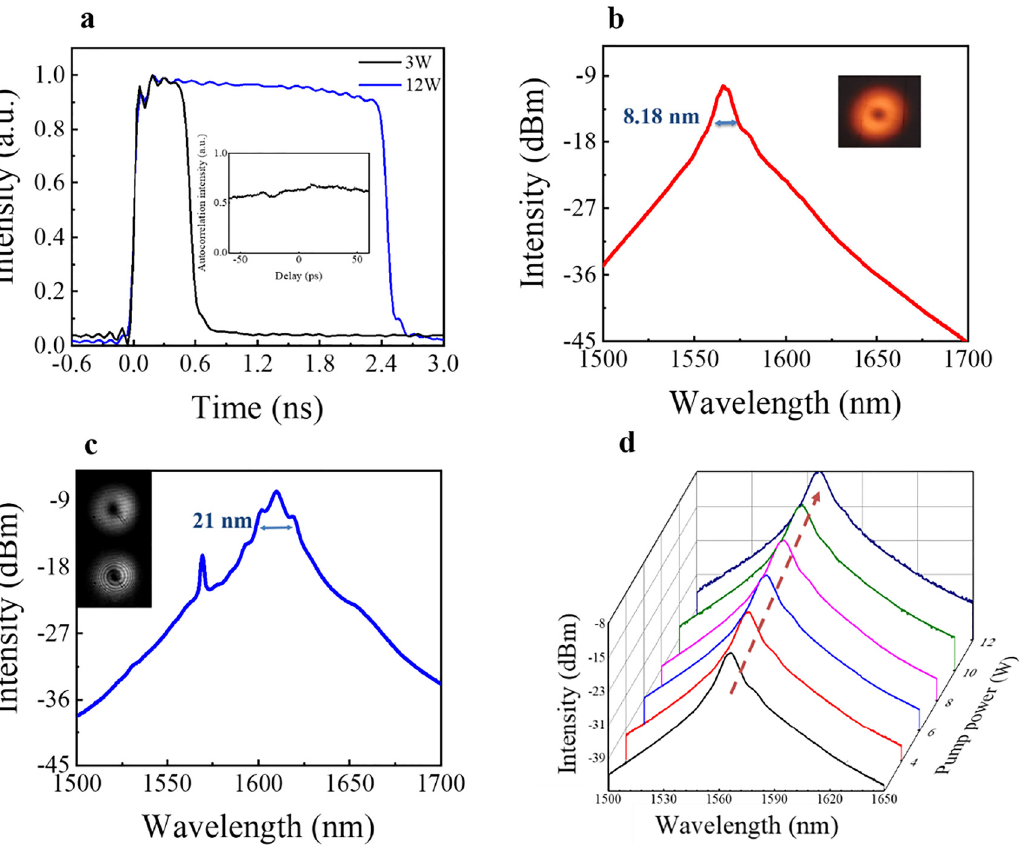
Figure5: (a)ThetemporalprofileofsingleDSRpulse(inset:autocorrelationtrace).DSRmode-lockingoutputspectrausingtheTAP-LPFGof(b) intra-cavity and (c) extra-cavity OVB and the insets are output OVB profiles. (d) The optical spectral evolution OVB mode from intra-cavity DSR MLFL as the pump power